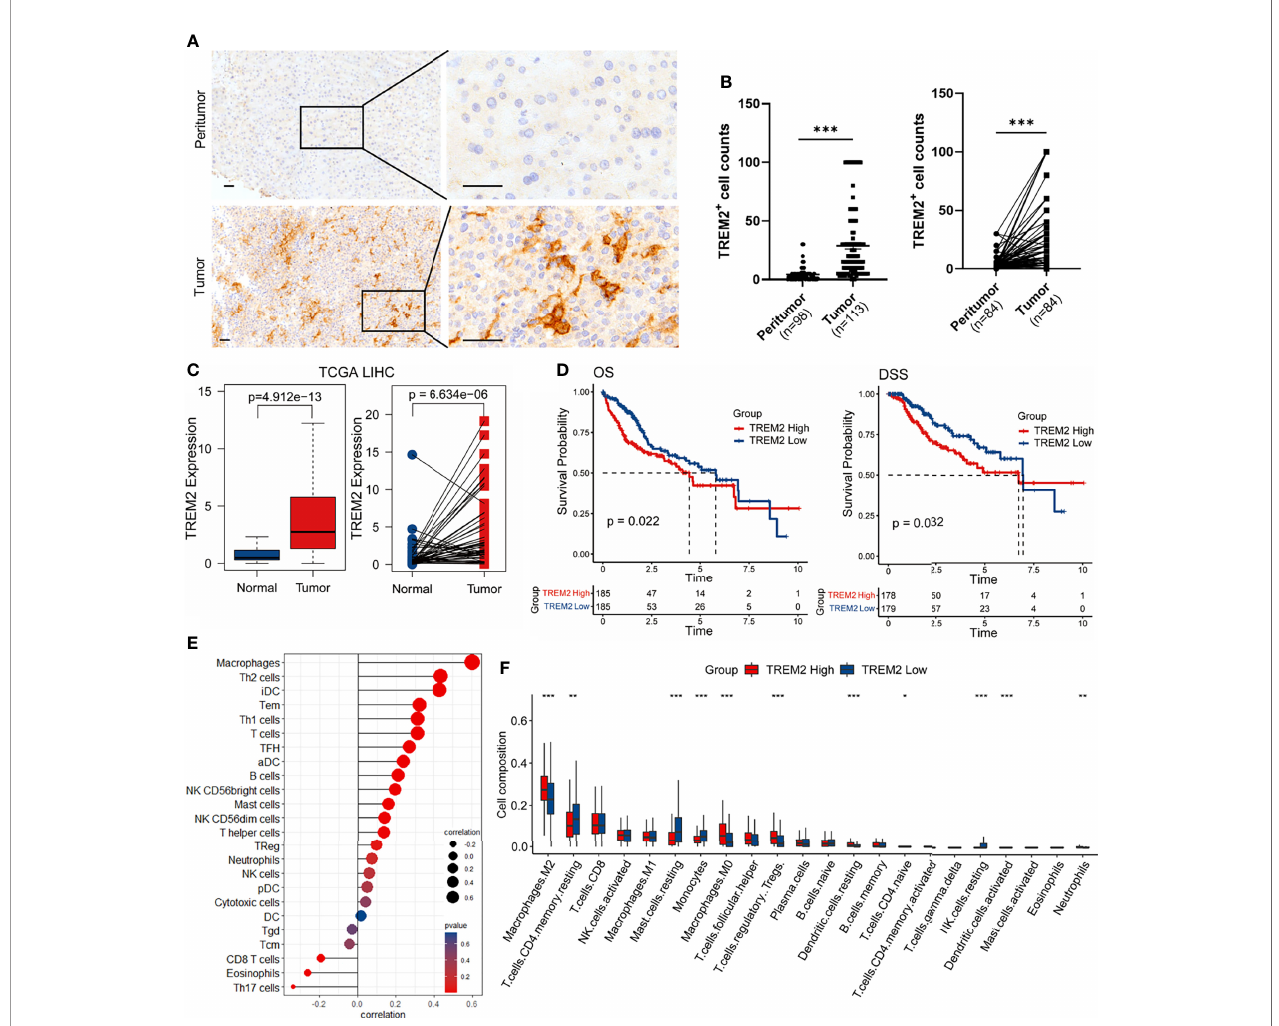
FIGURE 3 | TREM2 is upregulated in HCC and correlates with worse outcomes. (A) Representative images of immunohistochemical staining of TREM2 expression in HCC samples and peritumor tissues. The scale bar represents 50 m m. (B) Statistical analysis of TREM2 + cell counts in all (left) or paired (right) tumors and peritumor tissues from Validation cohort 2. Signi fi cance was determined by unpaired or paired Wilcoxon tests. (C) Box plots comparing TREM2 expression between all (left) or paired (right) tumor and normal samples from the TCGA-LIHC cohort. P values were determined by unpaired or paired Wilcoxon test. (D) Kaplan-Meier curves for overall survival (OS) and disease-speci fi c survival (DSS). Patients were divided into high and low TREM2 expression groups using the median value as the cutoff. P values were calculated using the log-rank test. (E) Lollipop plot depicting Spearman ’ s correlation coef fi cients between TREM2 expression and 24 immune cell types calculated by ssGSEA in the TCGA-LIHC cohort. (F) Box plot illustrating the in fi ltration of 22 immune cell types estimated by CIBERSORT in patients with high and low TREM2 expression levels. Signi fi cance was determined by unpaired Wilcoxon test. * P < 0.05, ** P < 0.01, *** P <